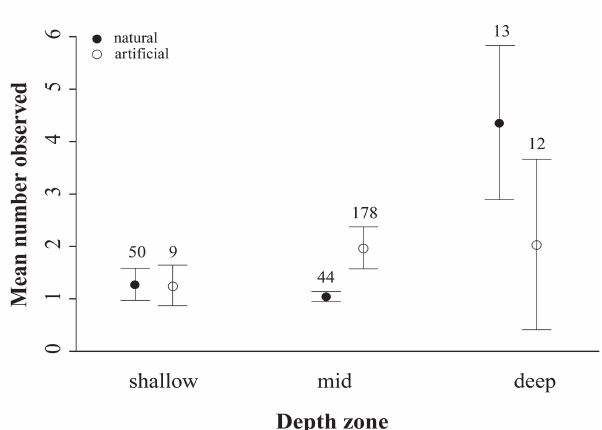
Fig. 5. Mean (+95% Confidence Interval) abundance of Epinephelus itajara observed by depth zone between habitats. Depth zones: shallow (0-14 m), mid (15-29 m) and deep (≥30 m). Numbers represent sightings between each deep zone and habitat.